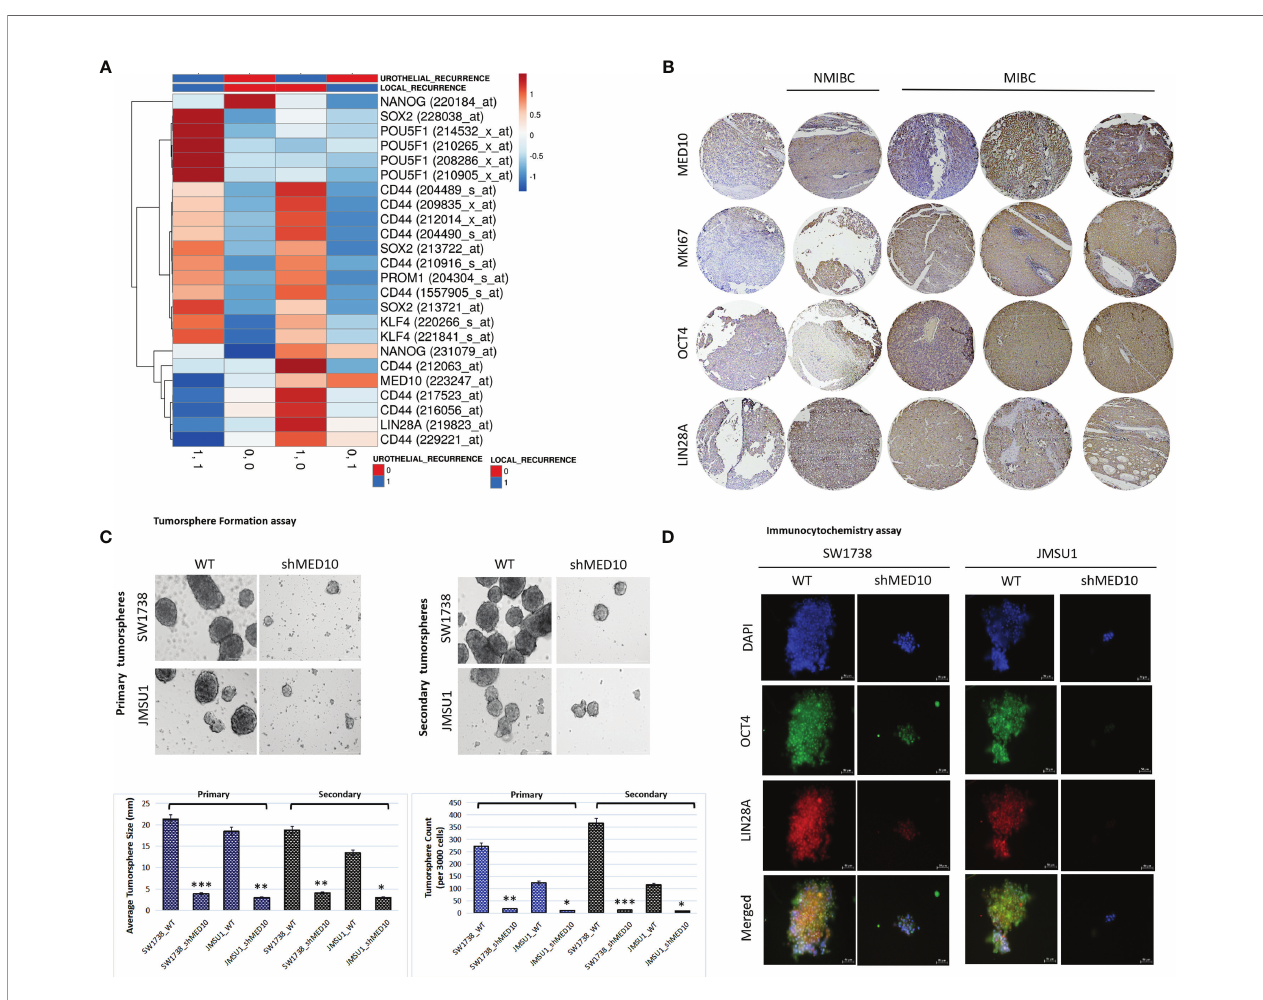
FIGURE 7 | shRNA-mediated targeting of MED10 in bladder urothelial carcinoma cells signi fi cantly attenuate their cancer stemness phenotype. (A) Heatmap showing the correlation between the expression of MED10, and stemness markers NANOG, SOX2, POU5F1/OCT4, CD44, PROM1/CD133, KLF4, and LIN28A in patients with urothelial recurrence or local recurrence from the AFFY_HG_U133_PLUS_2, GSE31684 cohort. Columns with similar annotations are collapsed by taking mean inside each group. Rows are centered; unit variance scaling is applied to rows. Both rows and columns are clustered using correlation distance and average linkage. 24 rows, 4 columns. (B) Immunohistochemistry photomicrographs of the differential expression of MED10, MKI67, OCT4, and LIN28A in benign, T1, T2, T3/4, or M1 tissue samples from the TMU-SHH UC cohort. Scale bar 200 m m. (C) Photomicrographs and histograms showing the effect of shMED10 on the formation of primary or secondary tumorspheres from SW1738 and JMSU1 cells. (D) Representative immuno fl uorescence images showing the effect of knocking down MED10 on the nuclear translocation and co-localization of OCT4A and LIN28A. DAPI served as nuclear marker. Scale bar 50 m m. *p < 0.05; **p < 0.01; ***p <